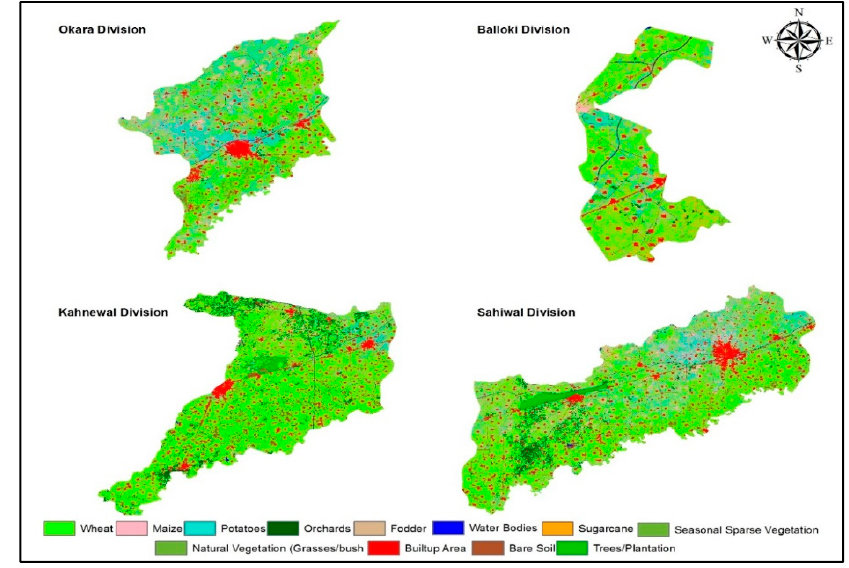
Figure 8. Crop classification-rabi season.